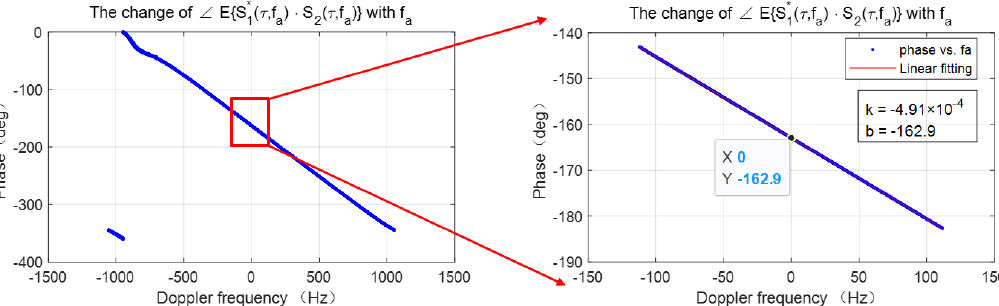
( τ , f a ) · S ( τ , f a ) } with f a 2 1